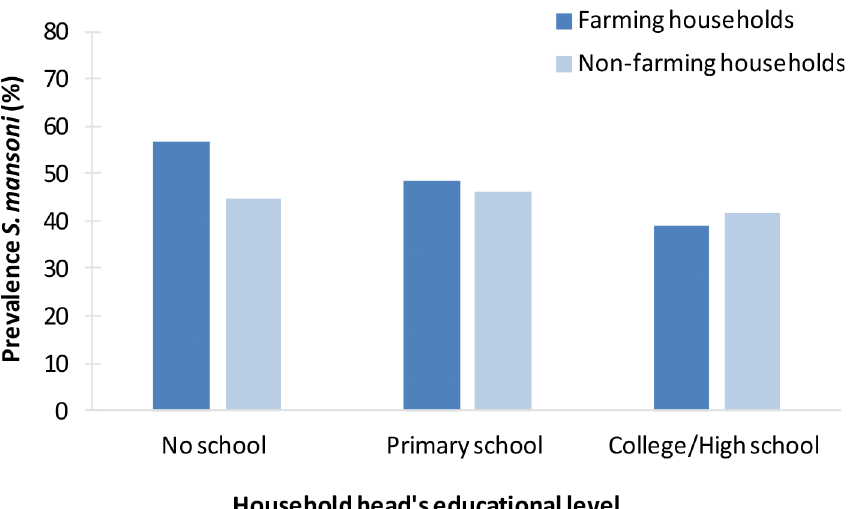
Fig 7. Example of socioeconomic inequalities in schistosomiasis: association between S . mansoni prevalence (%) and educational attainment of household head in the town of Man, western Côte d ’ Ivoire (2004 – 2005) [30]. The study was conducted in urban farming communities in the town of Man, western Côte d ’ Ivoire. A total of 113 farming households (586 individuals from all ages) and 21 nonfarming households (130 individuals from all ages) from six agricultural zones were interviewed, and stool samples were examined for S . mansoni . Infection prevalence was 51.4% in farming households and 44.6% in nonfarming households. Lower educational attainment was associated with higher infection prevalence in farming households ( p = 0.008) but not in nonfarming households. Infection prevalence was higher in poorer households but not statistically significantly